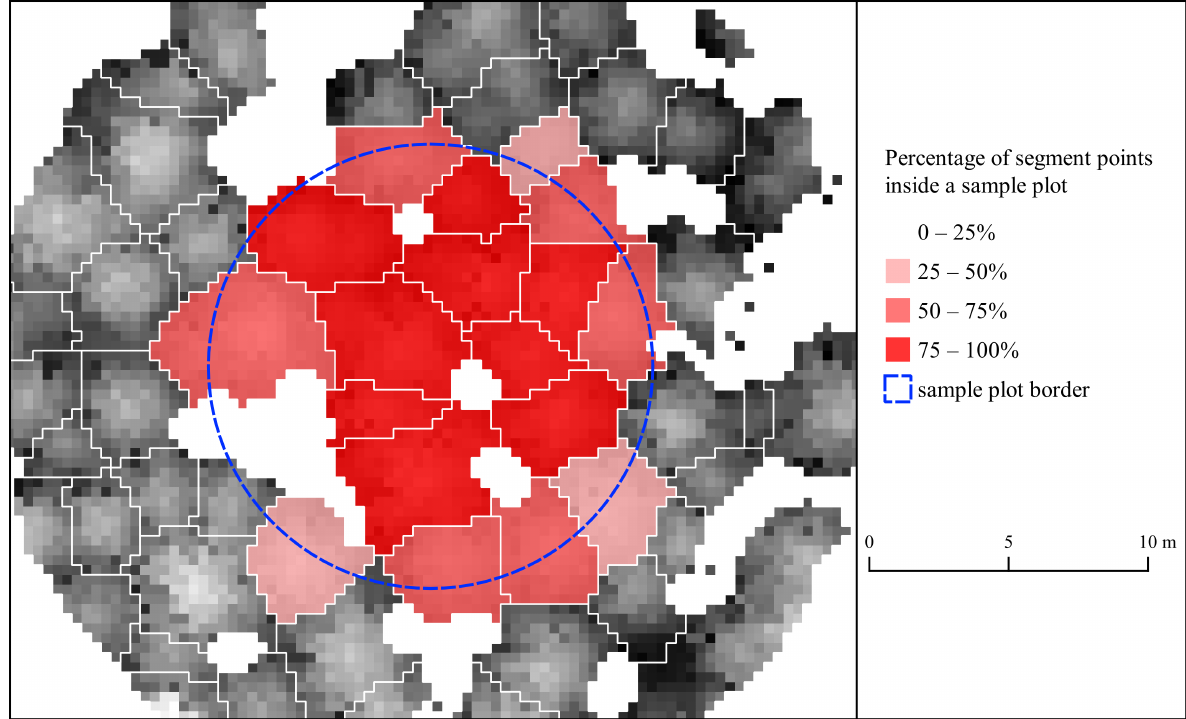
Figure 8. An example of determining tree membership in a sample plot based on the percentage of Airborne Laser Scanning derived points in a crown segment that are contained in the sample